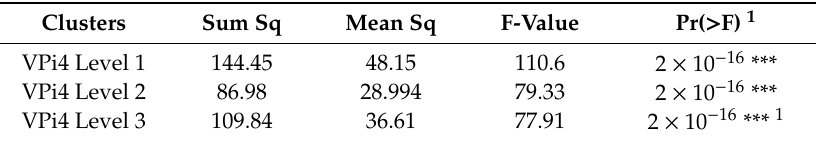
Table 5. Results of ANOVA test.